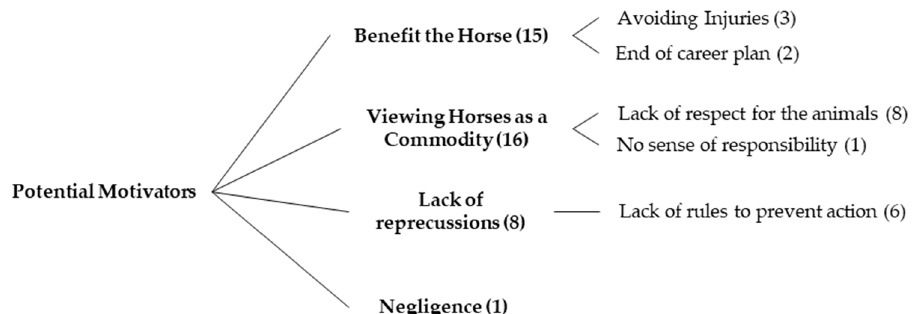
Figure 3. Taxonomic tree diagram of the four lowest referenced potential motivators behind the welfare concerns identified in the vignettes by respondents ( n = 14). Numbers in brackets indicate number of references for each category.